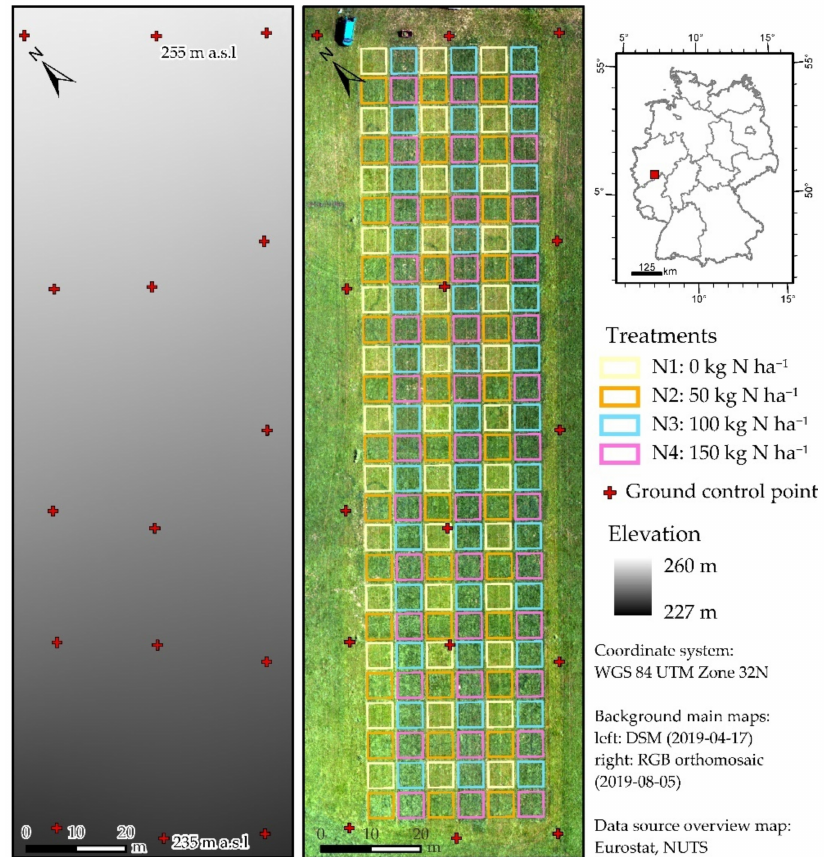
Figure 2. Map of study site Neunkirchen-Seelscheid (50.858986N, 7.312736E), Germany. ( Left ) Digital surface model. ( Right ) RGB